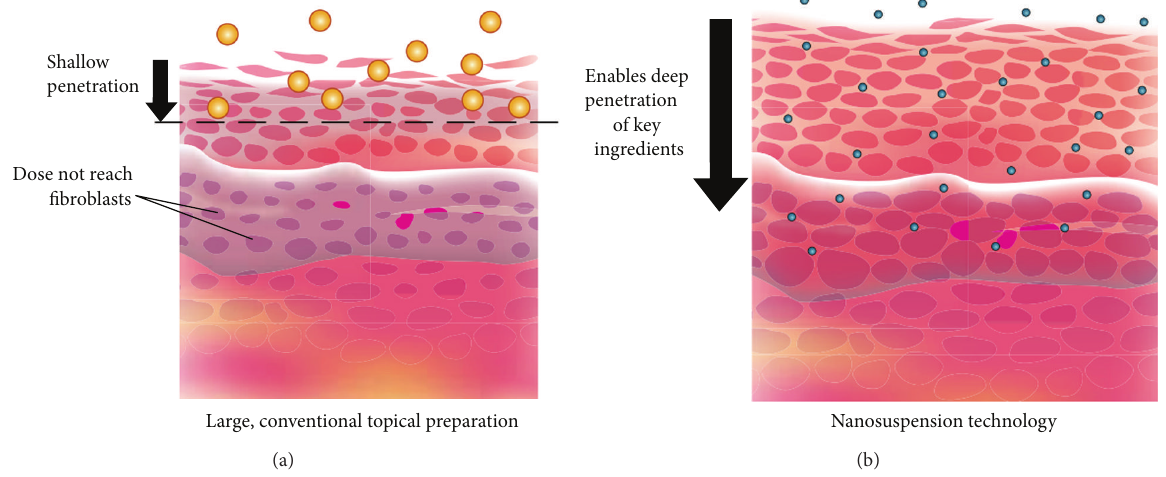
Figure 1: Penetration capability of nanosuspension over conventional topical